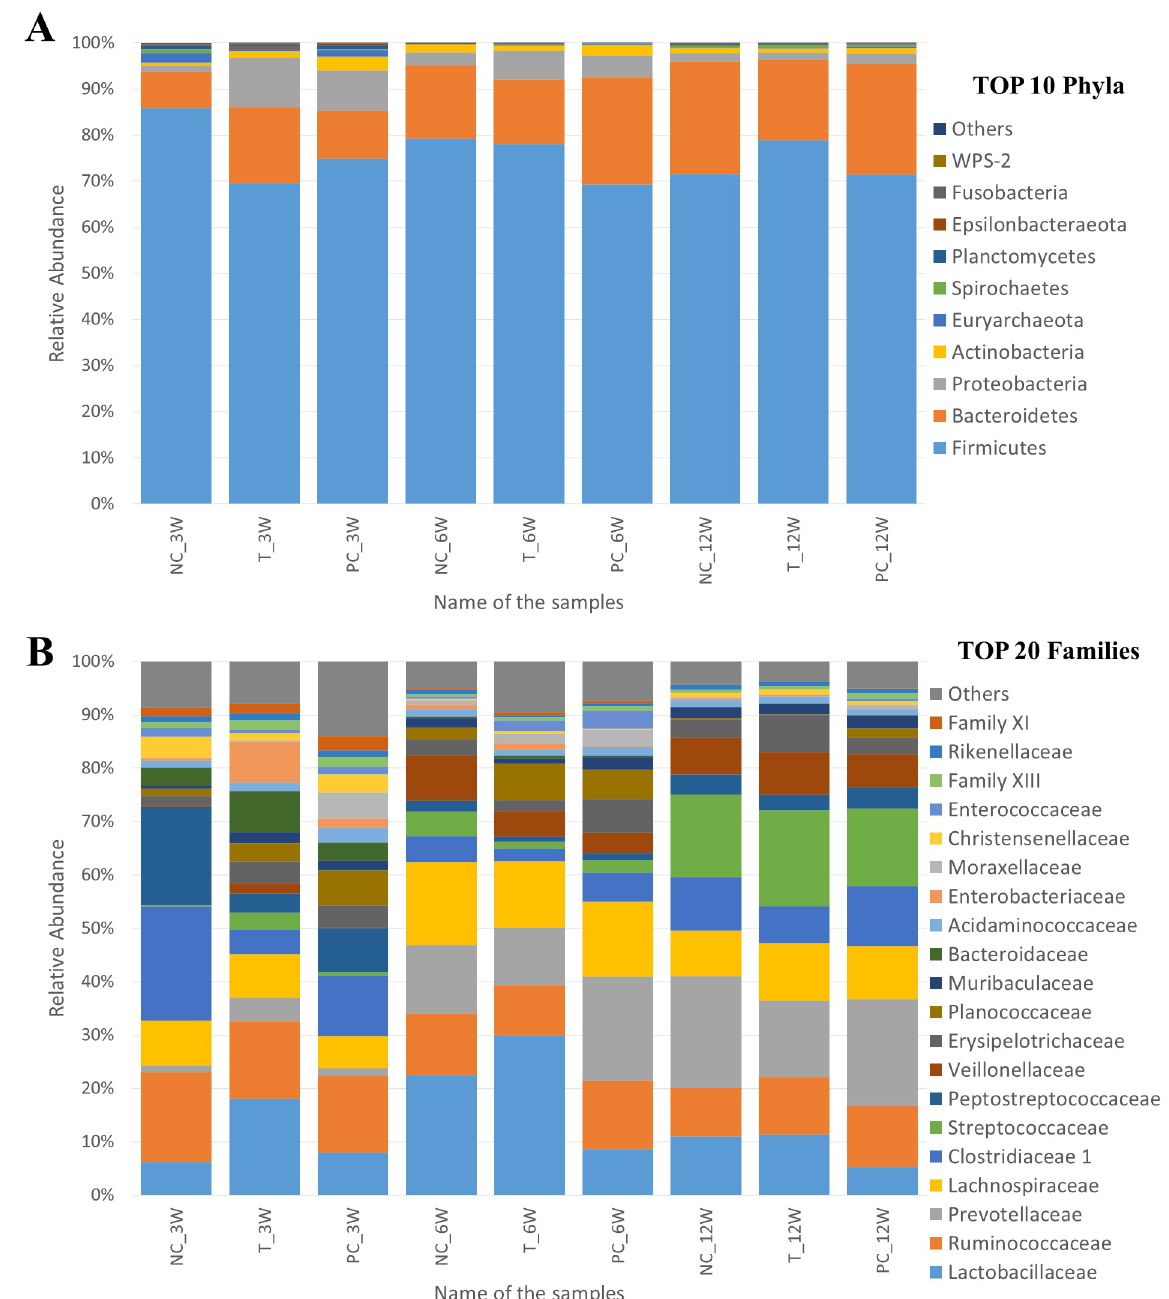
Fig 1. Relative abundance of bacterial community of the nine fecal samples. (A) Top 10 phyla. (B) Top 20 families. The main age-related changes at phylum level was a decrease of Proteobacteria (from 6.91% to 1.86%), and an increase of Bacteroidetes (from 11.58% to 21.98%). Interestingly, the largest change occurred in Fusobacteria, where the average relative abundance decreased more than 400-fold, yet the relative abundance remained lower than 0.2% except for T_3W (0.97%).